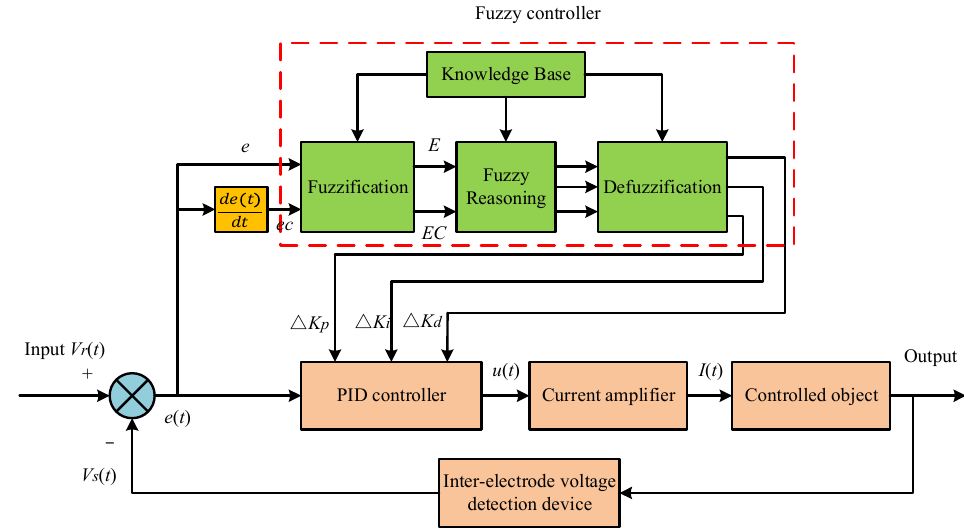
Figure 5. Schematic diagram of the inter-electrode voltage control system of the fuzzy PID control magnetic actuator for micro-EDM.